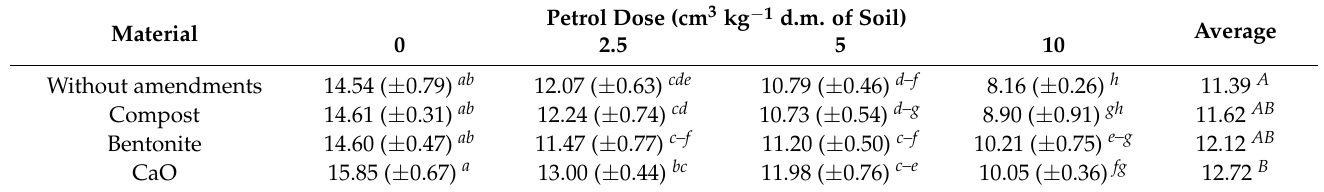
Table 2. Dry matter yield of aerial parts of maize— Zea mays L. (averages ± standard deviation, g kg − 1 d.m.).